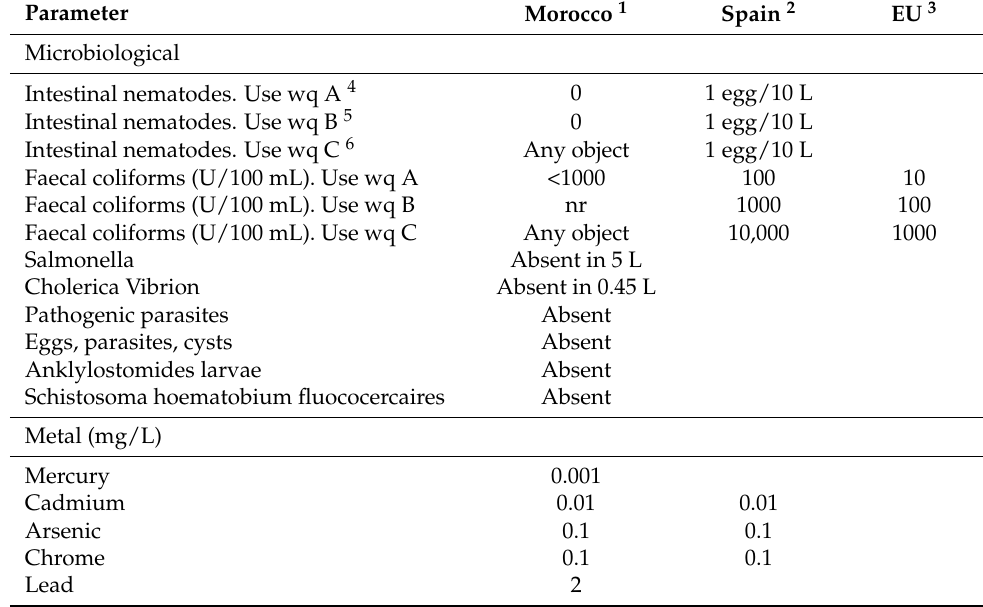
Table 2. Some quality standards of the Moroccan, Spanish, and new EU regulations for treated wastewater reuse for irrigation